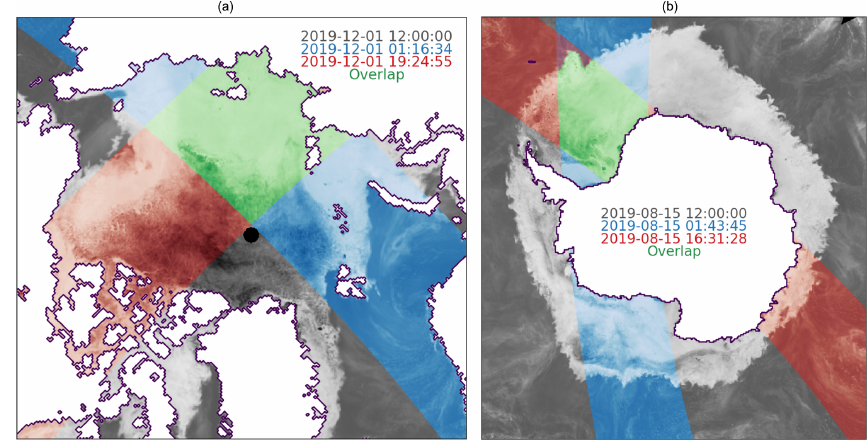
Figure 2. (a) Daily average map of AMSR2 36.5GHz V-pol T B on 1 December 2019 (greys) for the Arctic and two individual gridded swaths on the same day (blues: 01:16:34UTC; reds: 19:24:55UTC). The sea-ice region of overlap between the two swaths is highlighted in greens and is where S2S drift vectors can be computed. (b) Similar but for the Antarctic on 15 August 2019 (blues: 01:43:45UTC; reds: